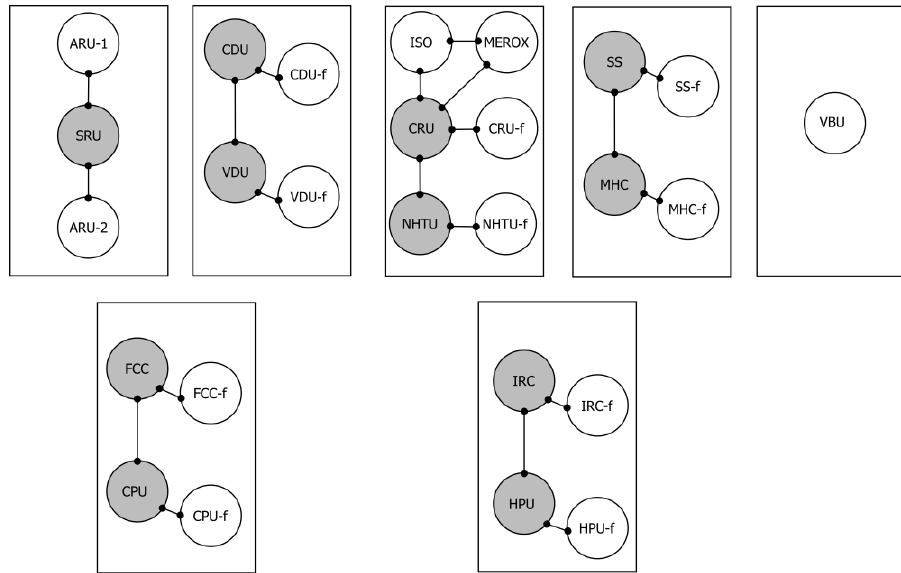
Figure 4. Graph illustrating allowed heat integration opportunities (indicated by edges between circles) when integration is allowed only between adjacent units within the same area (case c).